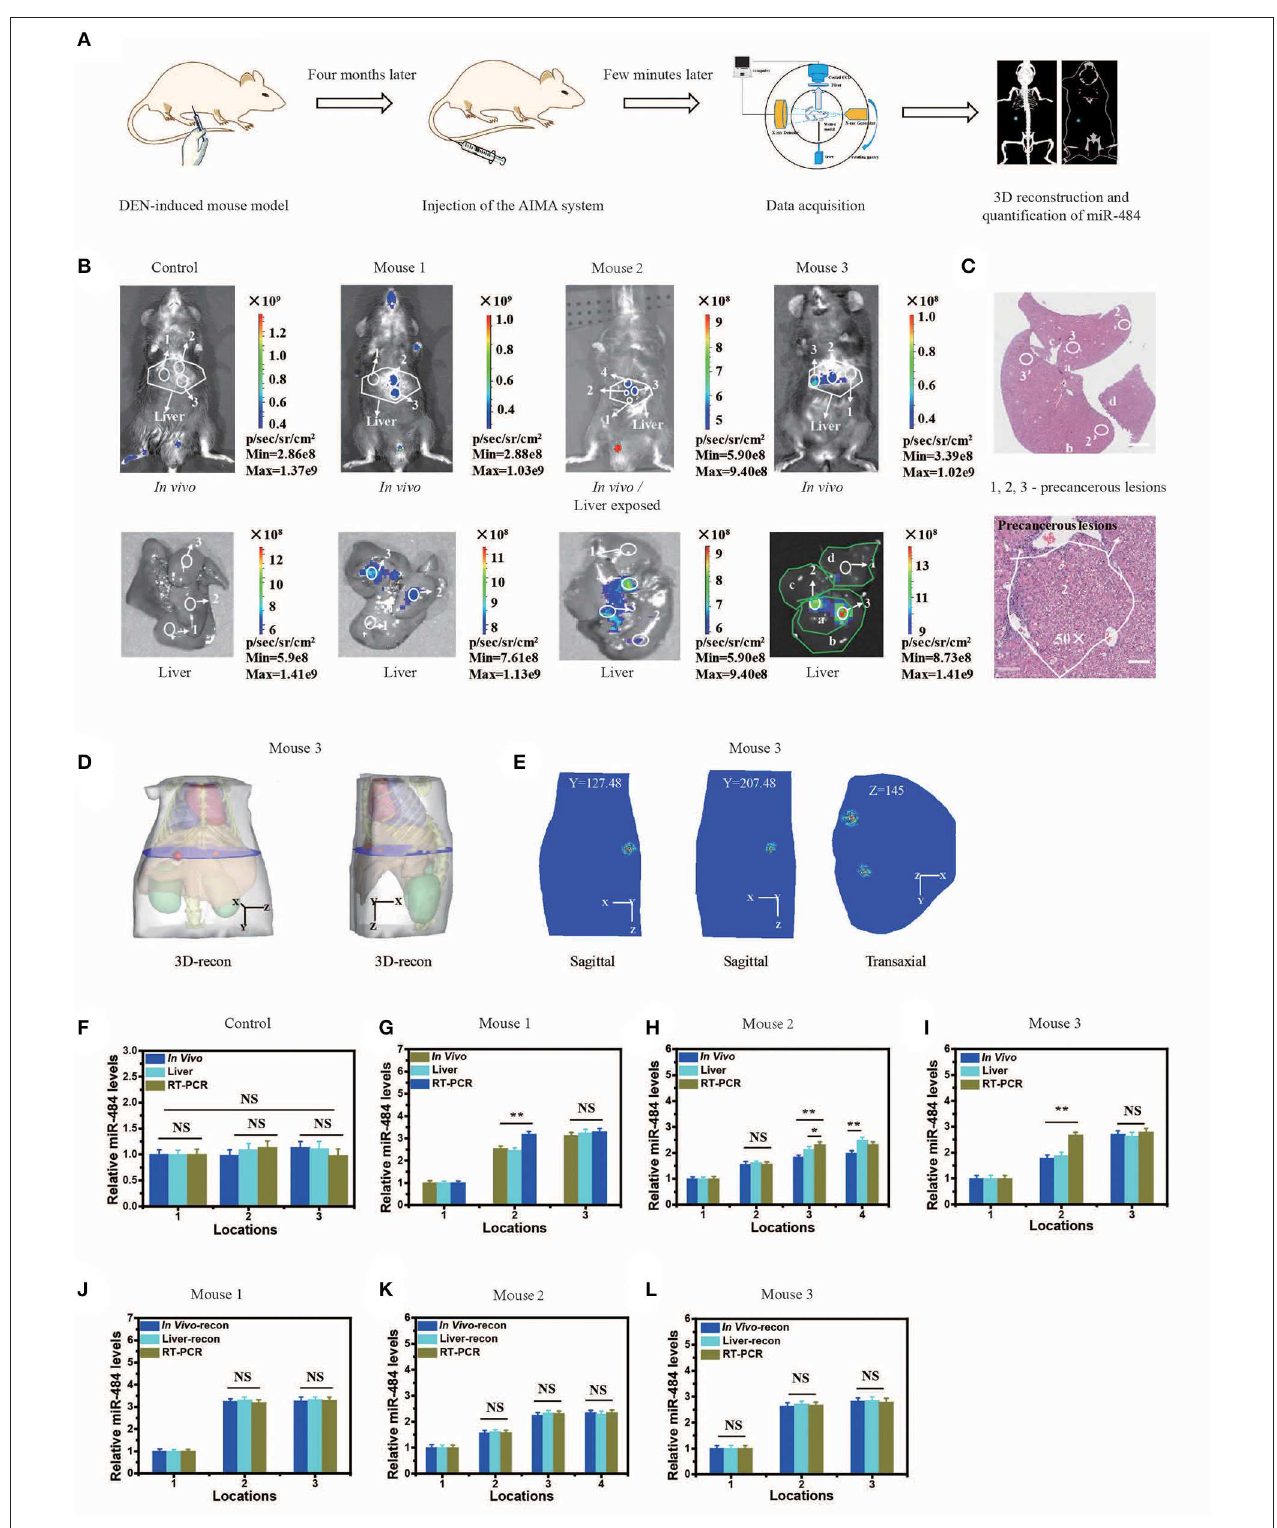
FIGURE 4 | Visualization and three-dimensional (3D) reconstruction of miRNA in vivo based on diethyl nitrosamine (DEN)-induced mice and the microscopic image of liver slices with hematoxylin and eosin (H&E) staining. (A) Schematic illustration of the quantification of miR-484, including DEN-induced mouse model; injection of the artificial intelligent signal amplification (AISA) system (included SQ and FP); data acquisition; 3D reconstruction and quantification of miR-484. (B) Upper panel: